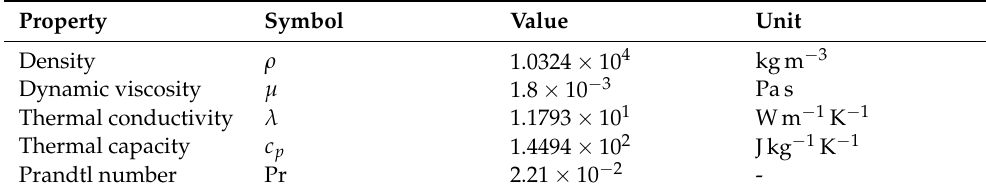
Table 1. LBE properties evaluated at T 0 from correlations in